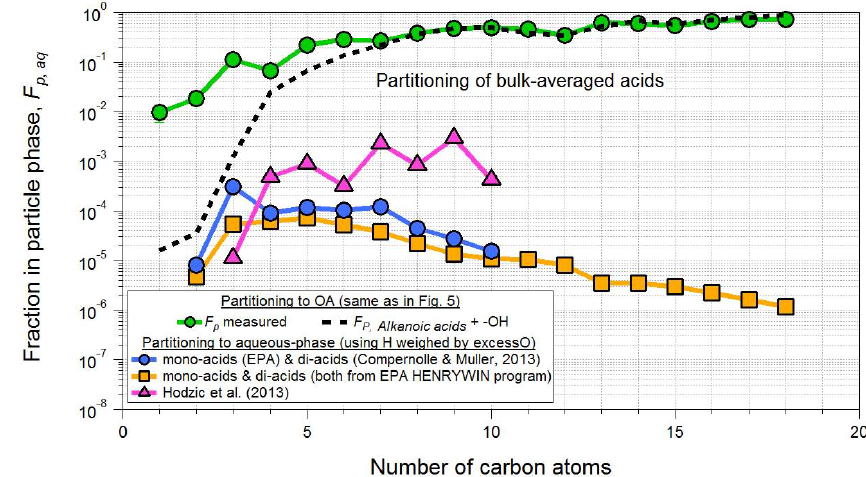
Fig. 6. Campaign average partitioning to the aqueous phase ( F p , aq ) for bulk-averaged acids ( H values used for this estimation are shown in Fig. S7). Also shown are measured and modeled OA F p from Fig.